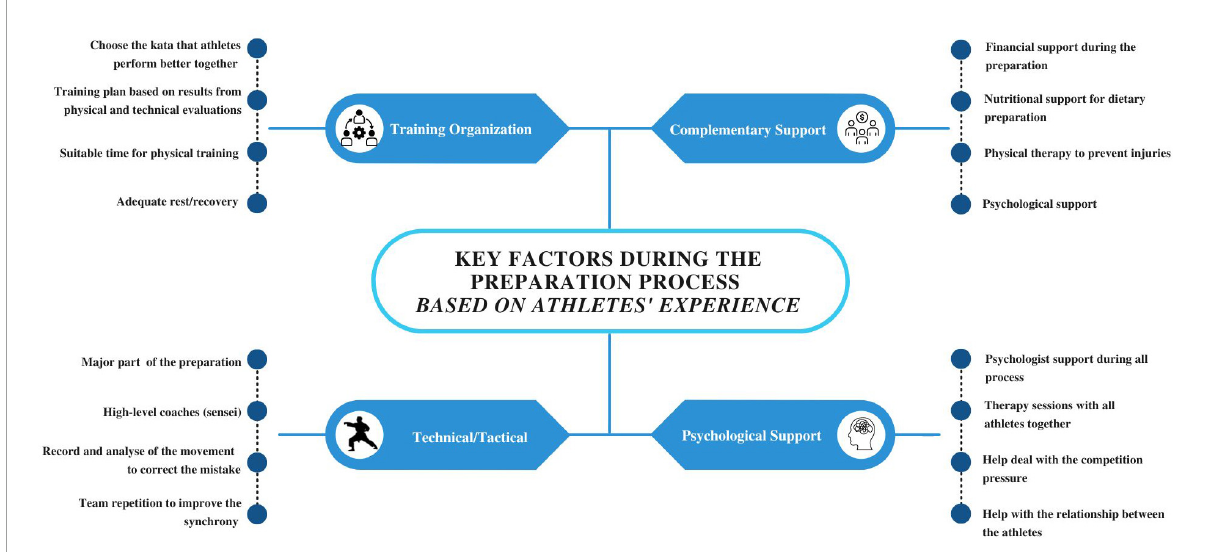
FIGURE1 The athletes’ perception of the key factors during the preparation process for major kata competitions.